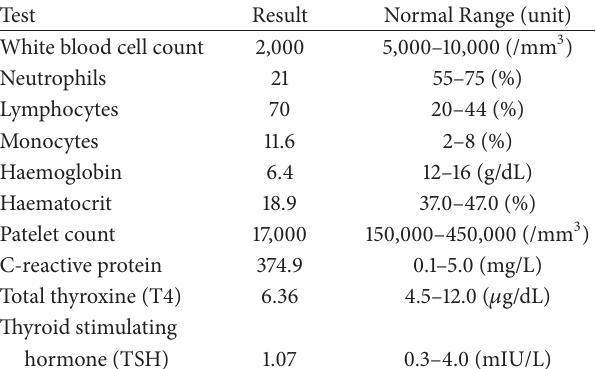
Table 1: Results of the patient’s laboratory